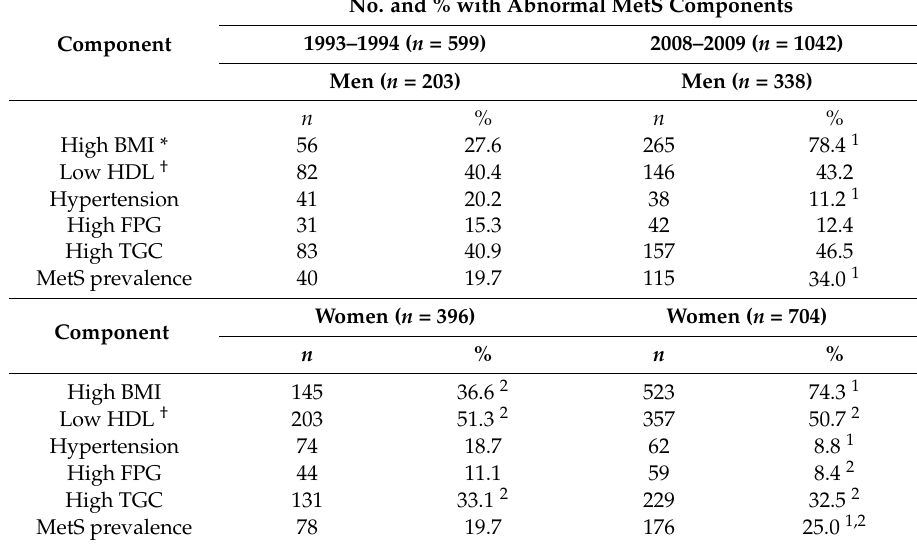
Table 2. Prevalence of individual metabolic syndrome components and the metabolic syndrome among Central and South American men and women from 1993–1994 and